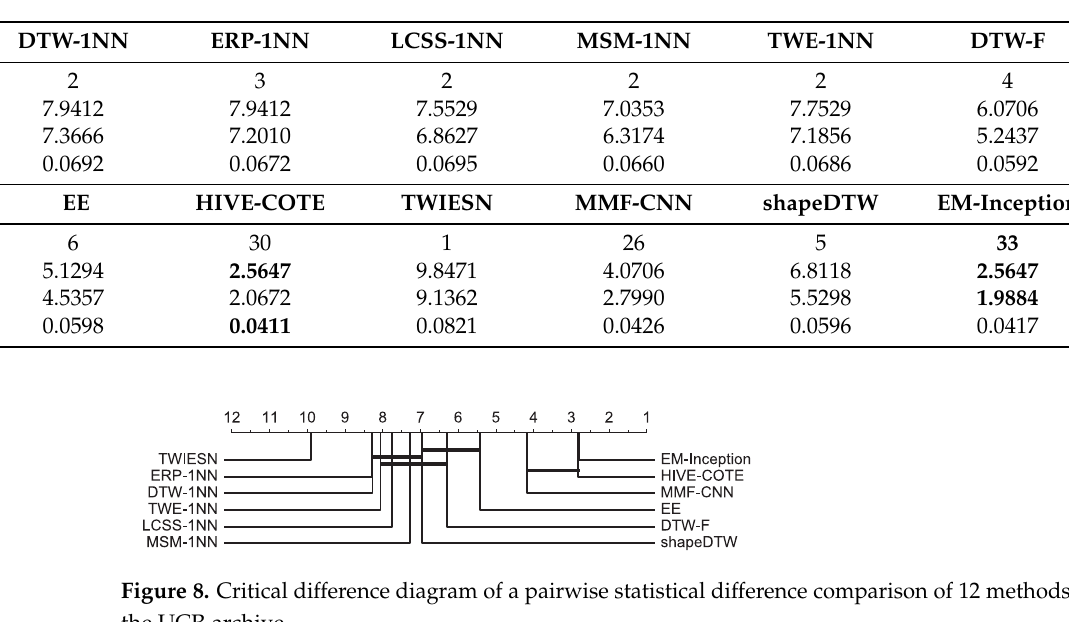
Table 2. Performance of 12 different methods on the UCR archive.